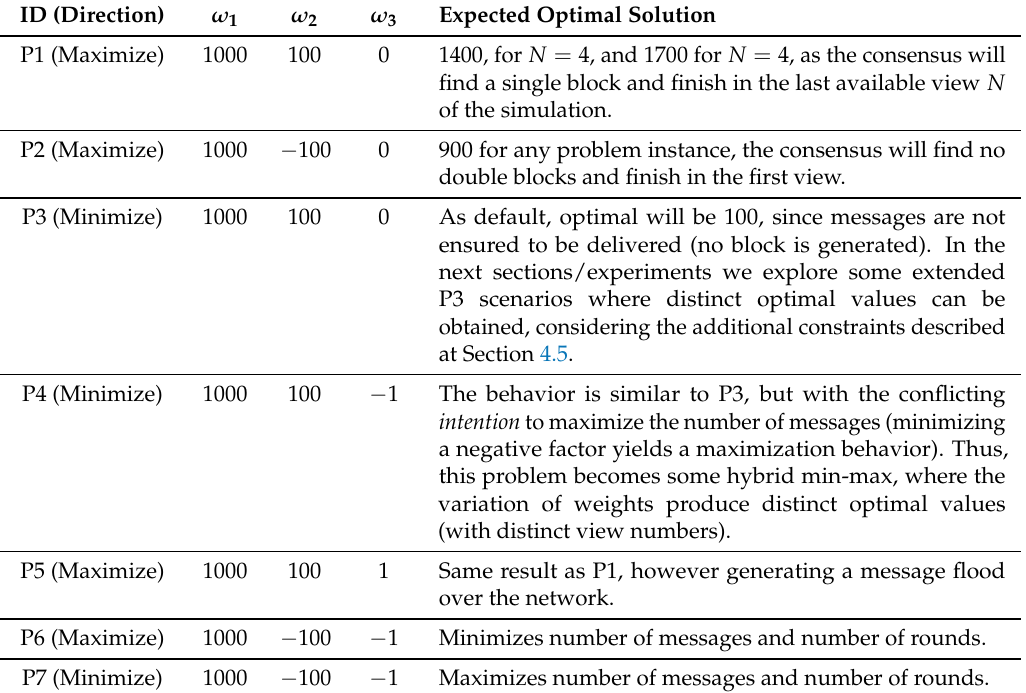
Table 2. Optimization directions and weights in seven different